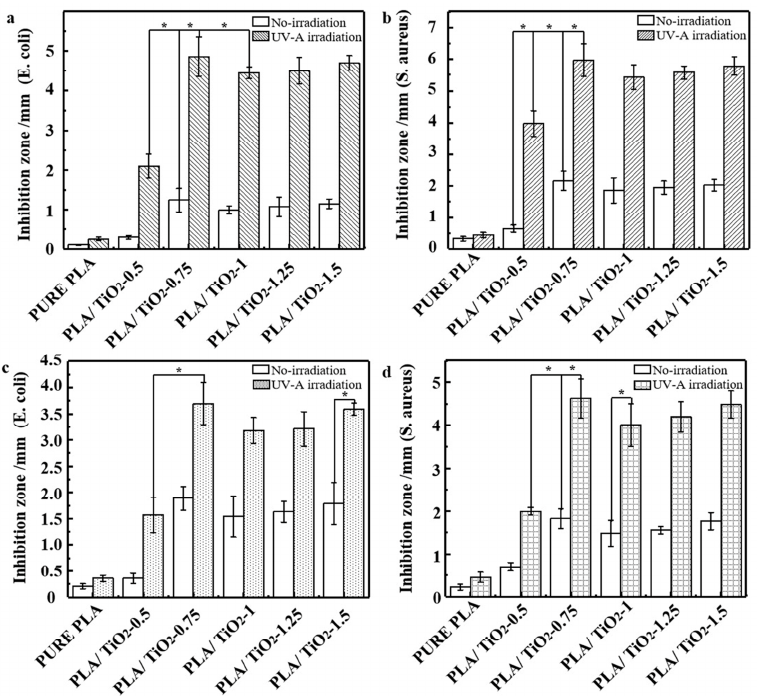
Figure 8. Inhibition zones of E. coli and S. aureus as a function of TiO 2 nanoparticle content in PLA nanofibers and films under light irradiation conditions: ( a , b ) nanofibers; ( c , d ) films. Columns with * mean significantly different ( P ≤ 0.05).